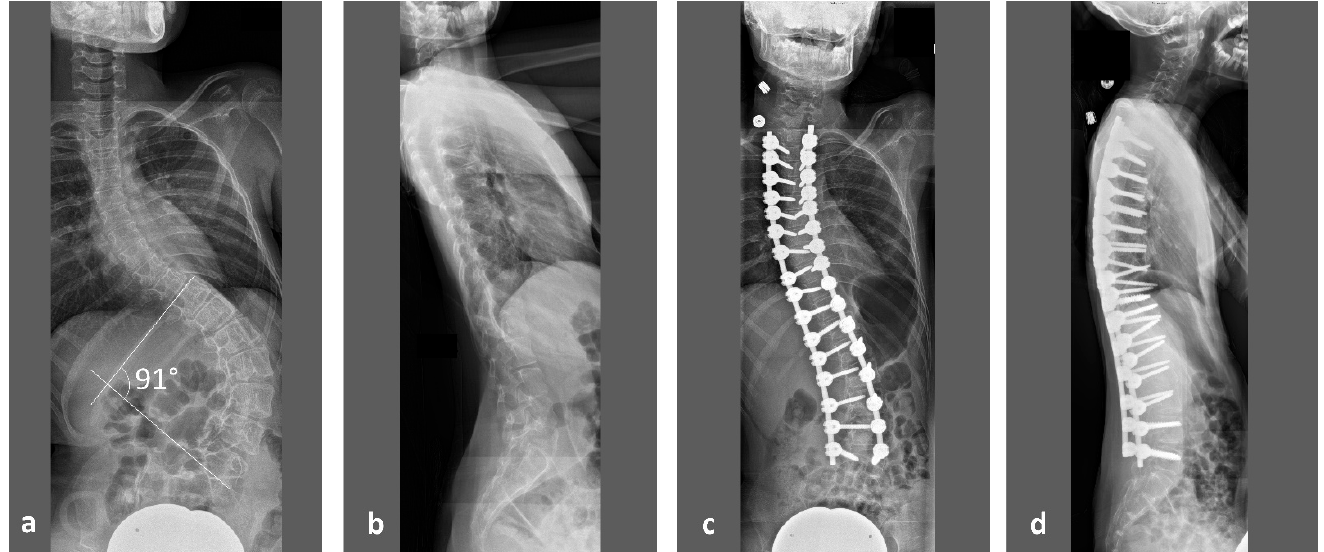
Figure 1. 13-years-old, non-ambulatory girl with RTT with severe neuromuscular scoliosis and thoracic hyper-kyphosis. ( a ) Preoperative anteroposterior (ap) and ( b ) lateral sitting radiographs with a scoliosis angle of 91°. ( c ) Postoperative ap and ( d ) lateral sitting radiographs with dorsal spinal fusion from T (thoracic) 2 to L (lumbar) 5.